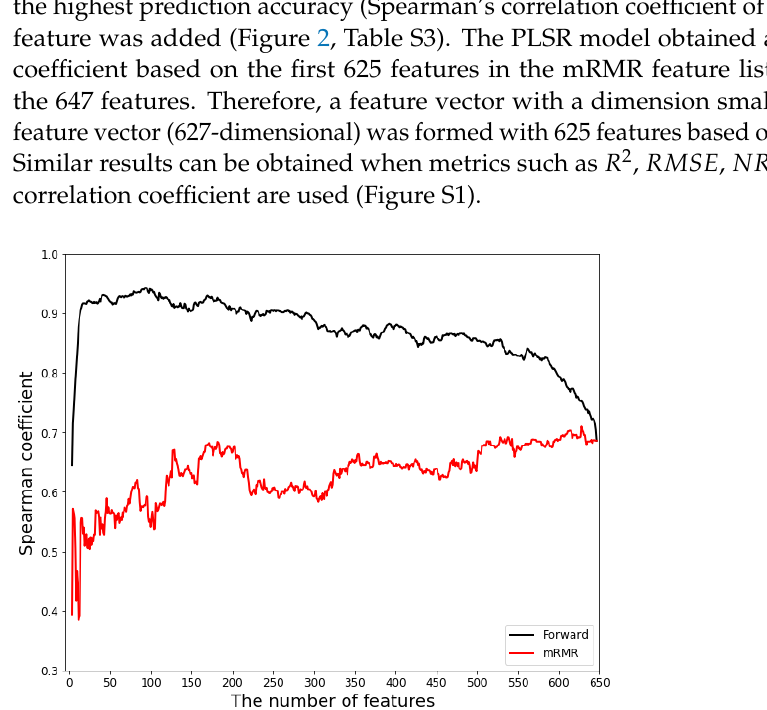
Figure 2. Curves of Spearman’s correlation coefficient produced by mRMR features (red line) and the forward feature searching strategy (black line). The mRMR method combined with the forward feature searching strategy has a good performance in feature selection. mRMR and Forward represents the minimum redundancy-maximum relevance method and forward feature searching strategy,